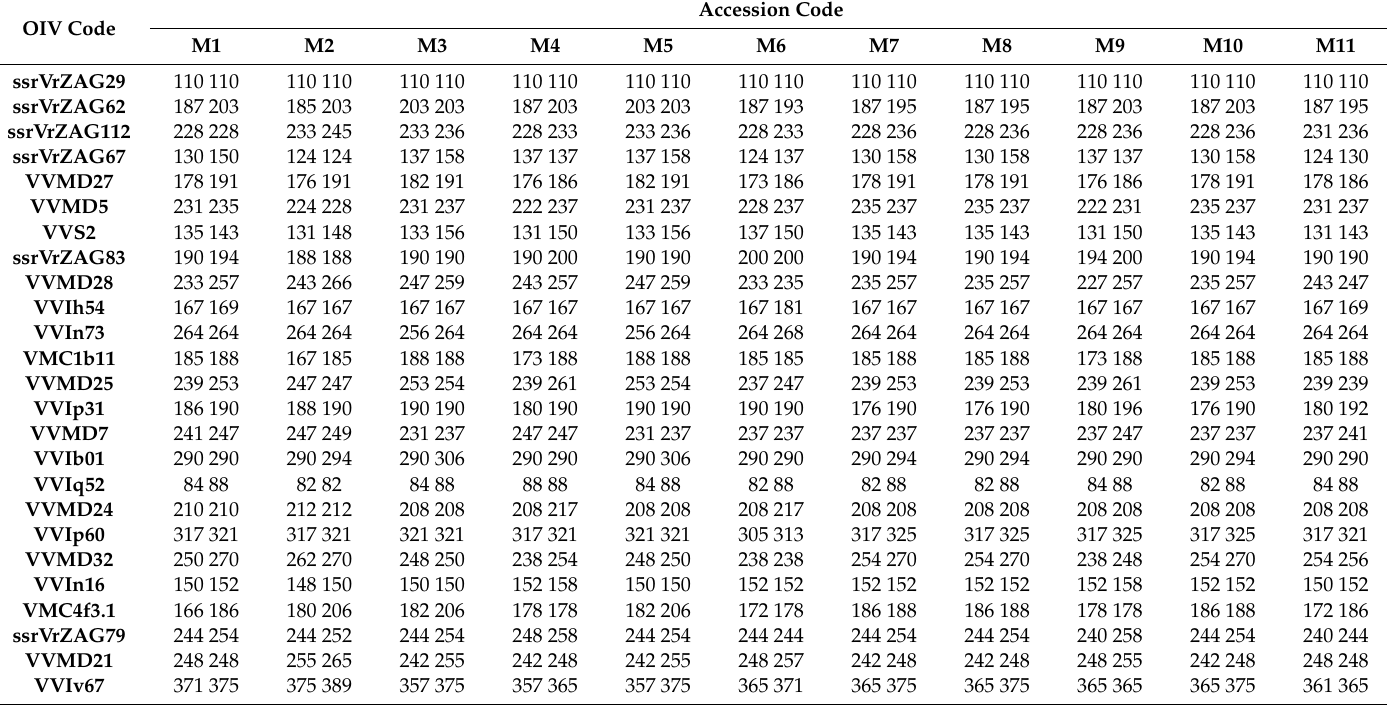
Table 1. Microsatellite profile of 11 grapevine accessions located in Axarquia (Malaga, Spain) analyzed at 25 microsatellite